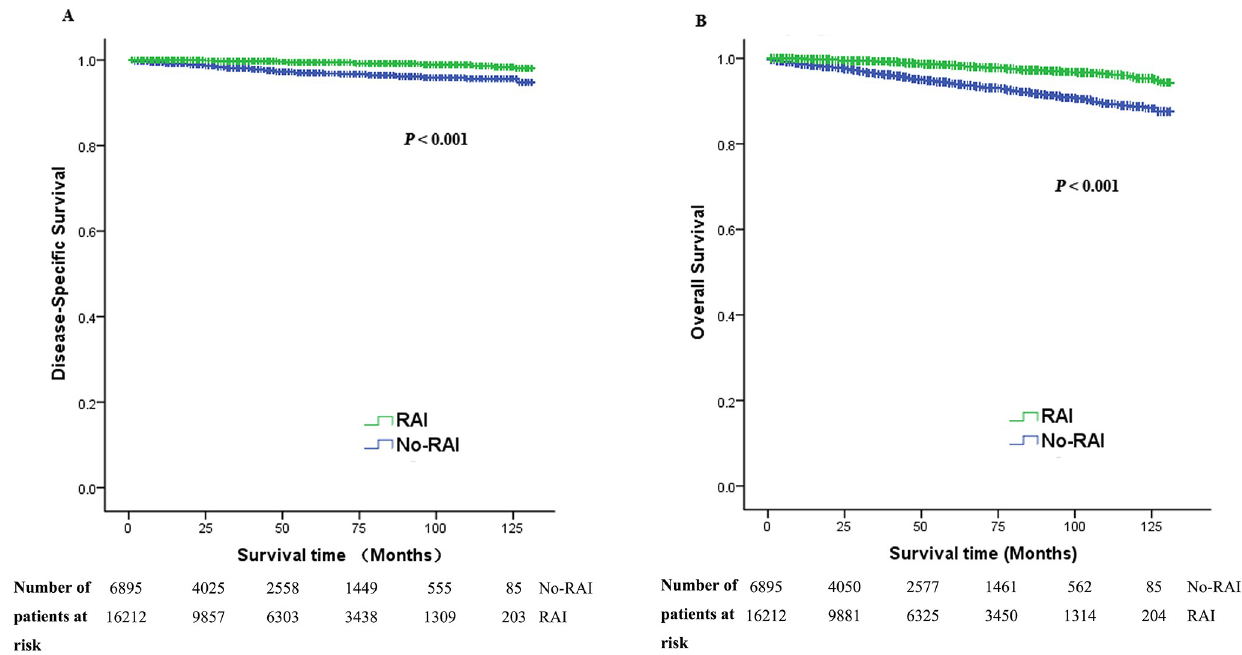
Fig 1. Unadjusted disease-specific survival (A) and overall survival (B) difference for intermediate-risk PTC patients according to RAI therapy.